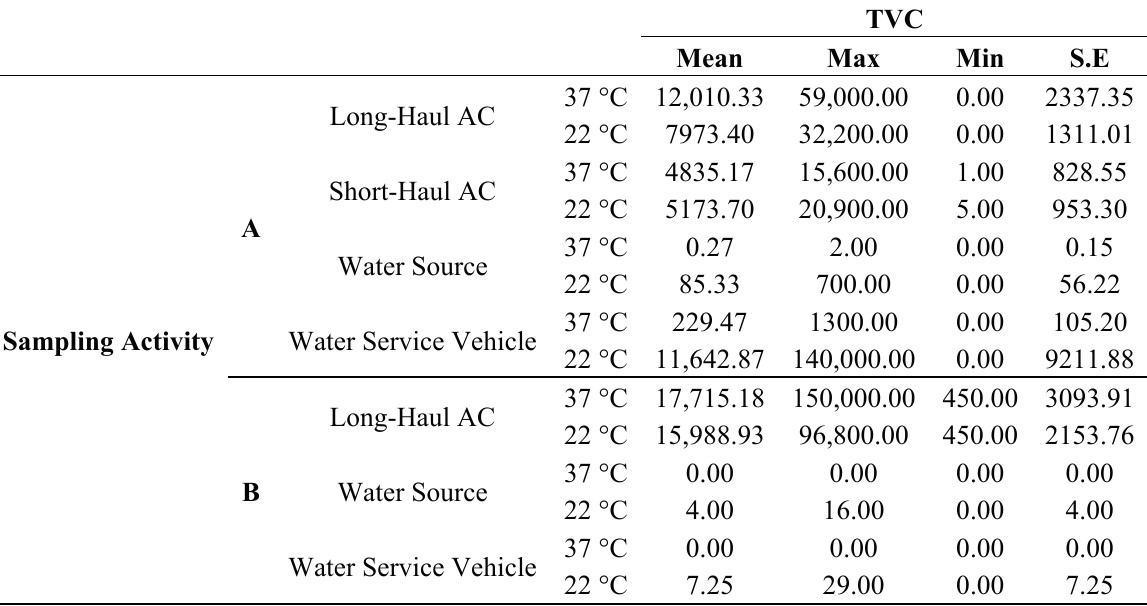
Table 8. Microbiological analysis for sampling activity A and B across the aircraft, the source water and the water service